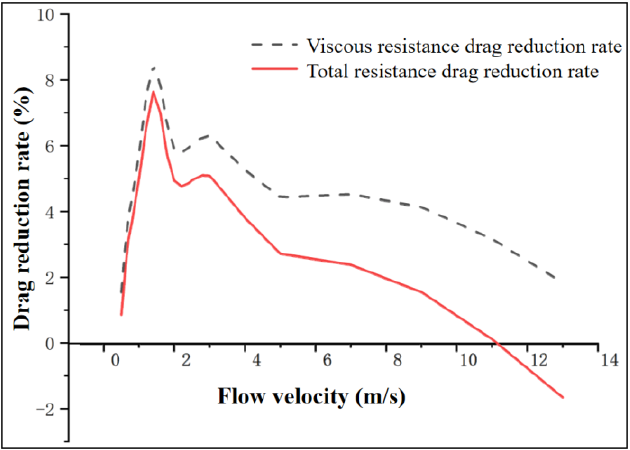
Figure 11. The relation curve of flow velocity and drag reduction rate.